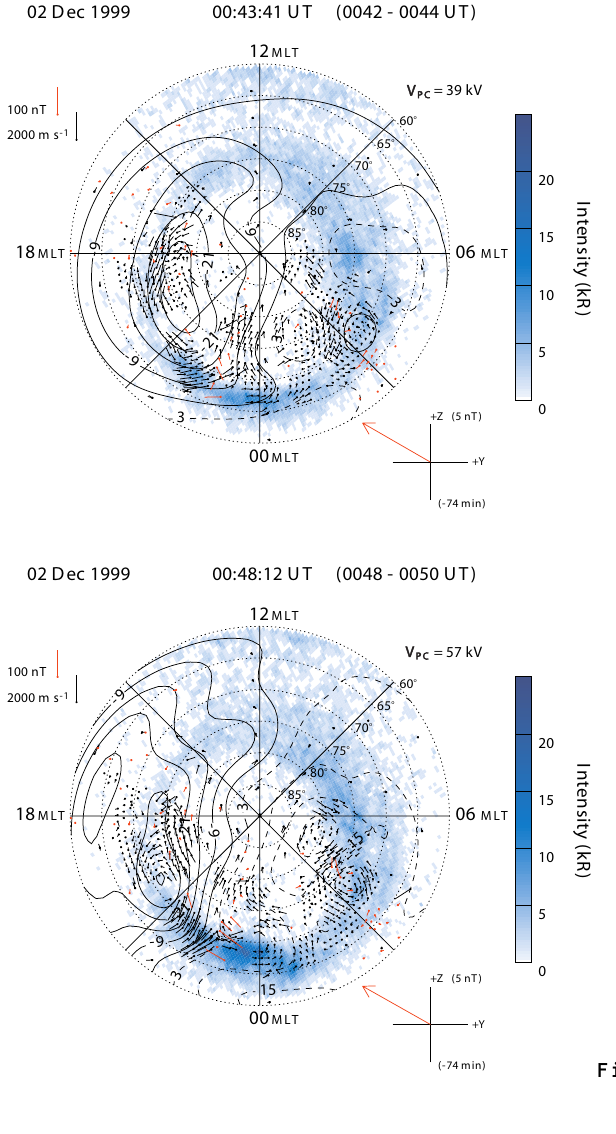
Figure 7d shows images, centered at 01:04:32